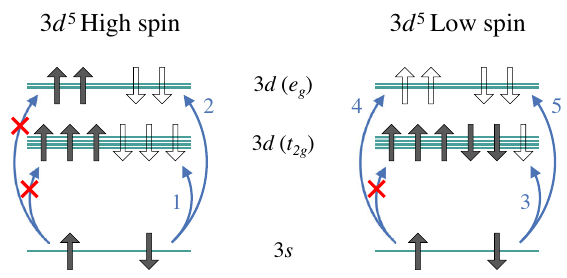
FIG. 10. Schematic diagram of the s -NIXS excitation process for a 3 d 5